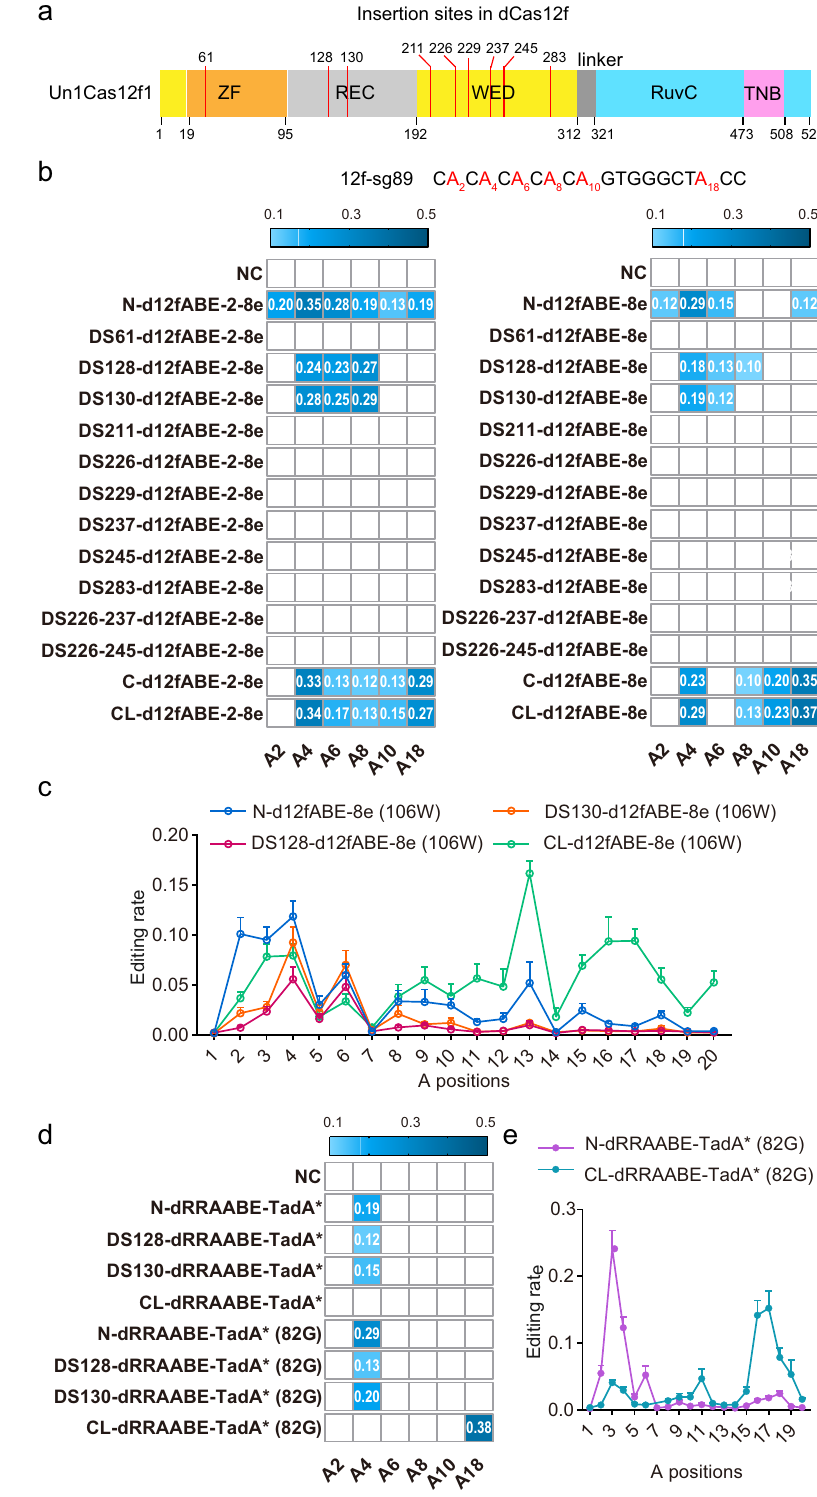
Fig.1|Developmentoffunctionald12fABEswithhighactivitiesanddiversi fi ed scopes. a Diagram showing Cas12f domain organization and internal fusing sites (red lines) for the generation of potential miniABEs. b Heatmaps from left to right showing A-to-G editing frequencies of d12fABEs-2-8e and d12fABEs-8e in blue gra- dientcolor.Various potentiald12fABEs are generated by fusing TadA-8emonomer (hereafter 8e), dimer (hereafter 2-8e) to N-, C-terminus or internal sites of d12f. Editing activities were evaluated against sgRNA 12f-sg89. c A-to-G editing fre- quencies at each adenine position across 12 endogenous sites were quanti fi ed and